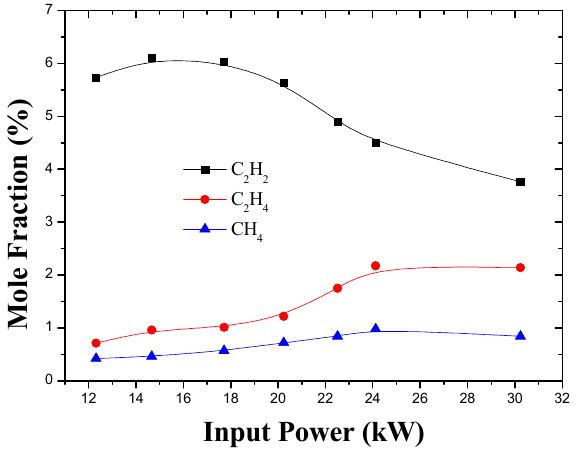
Figure 10. Variation in composition of product gas with varied input power (Carrier gas flow rate: 1 Nm 3 /h; working gas flow rate: 5 Nm 3 /h; feed rate: 17.65 g/min; magnetic flux intensity: 0.077 T).